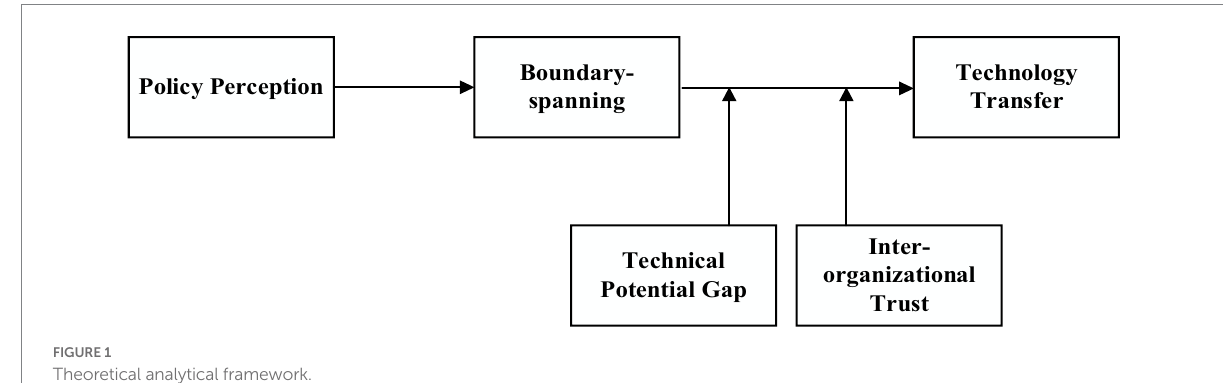
FIGURE 1 Theoretical analytical